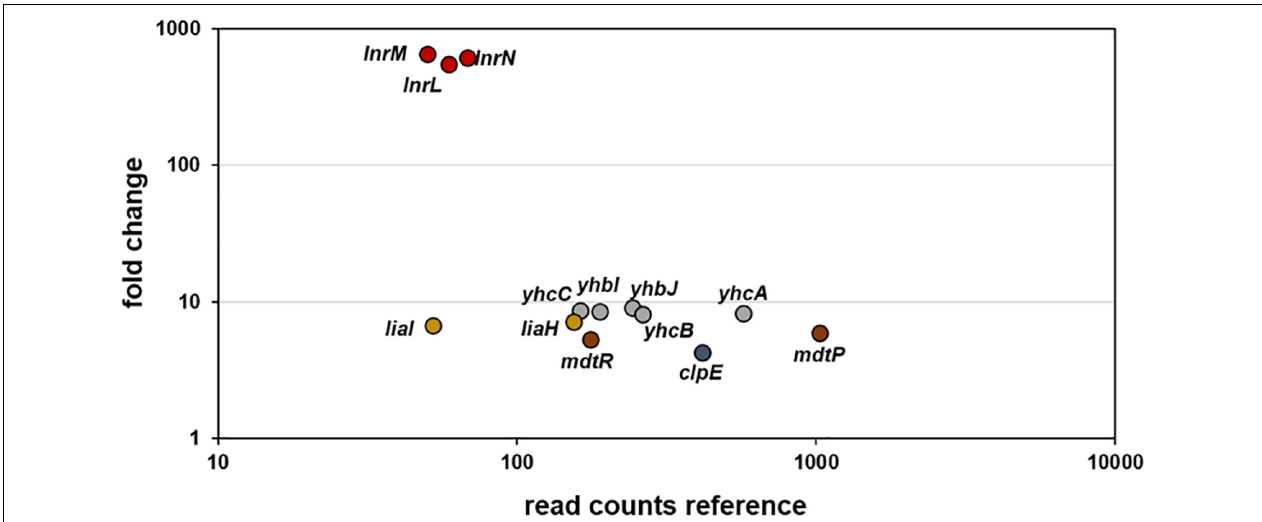
FIGURE 2 | RNA-sequencing (RNA-seq) profile of B. subtilis upon amphotericin B treatment. Visualization of altered gene expression in B. subtilis upon 10 µ g ml − 1 amphotericin B exposure after 10 min, compared to non-induced control samples. Fold change of elevated RNA-seq counts are plotted over read counts in the reference condition. Same colored dots highlight genes encoded within an operon. For further details, see Table 3 .